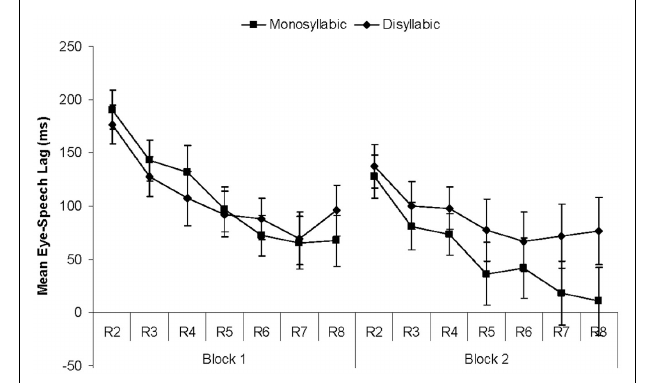
FIGURE 5 | Results of Experiment 1. Mean eye–speech lags (ms) per block and repetition (R2 through R8) for monosyllabic and disyllabic items.